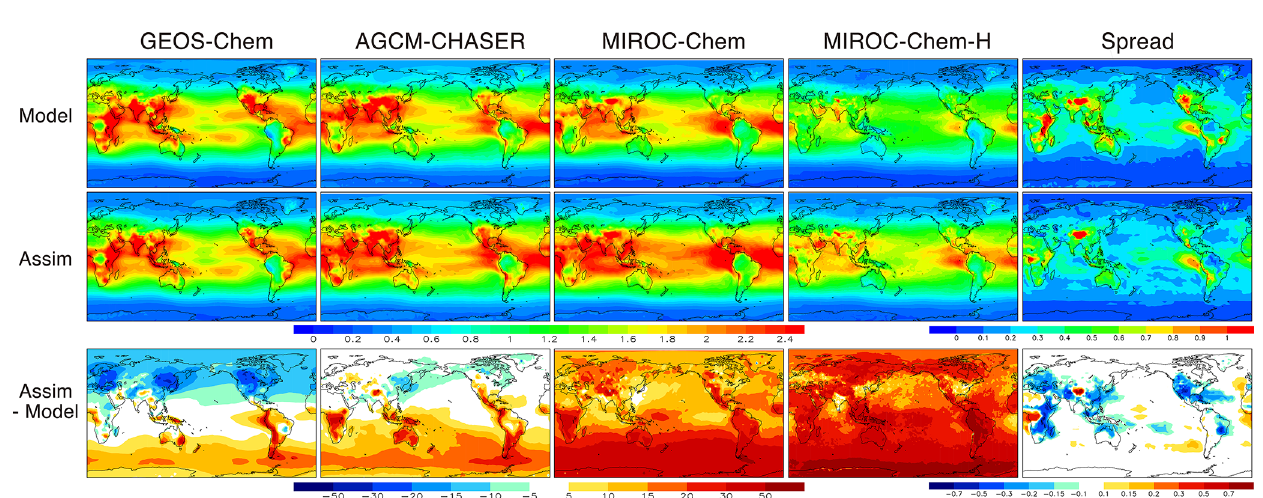
Figure 13. Global distributions of annual mean OH concentrations (10 6 moleculescm − 3 ) averaged over the troposphere (from the surface to 300hPa) from the control runs (upper panels), data assimilation analyses (middle panels), and differences between the data assimilation analyses and the control runs (bottom panels, %). The figures on the right show the standard deviation among the four systems for the control runs (right top) and data assimilation analyses (right middle). The right bottom figure shows the difference in the multi-model standard deviation between the data assimilation analyses and the control runs (10 6 moleculescm − 3